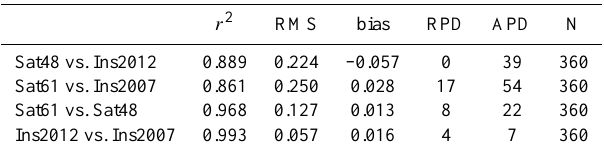
Table 6. Cross-comparison between two SeaWiFS-OWP matchup datasets: the current and the one performed by Volpe et al. (2007). First row shows the comparison between the new in situ dataset (Ins2012) and the SeaWiFS CHL derived using SeaDAS v4.8 (Sat48). Second row refers to SeaDAS v6.1 (Sat61) against the Volpe’s in situ data (Ins2007). Third and fourth rows show the difference between the two SeaDAS versions and the two in situ datasets, respectively. r 2